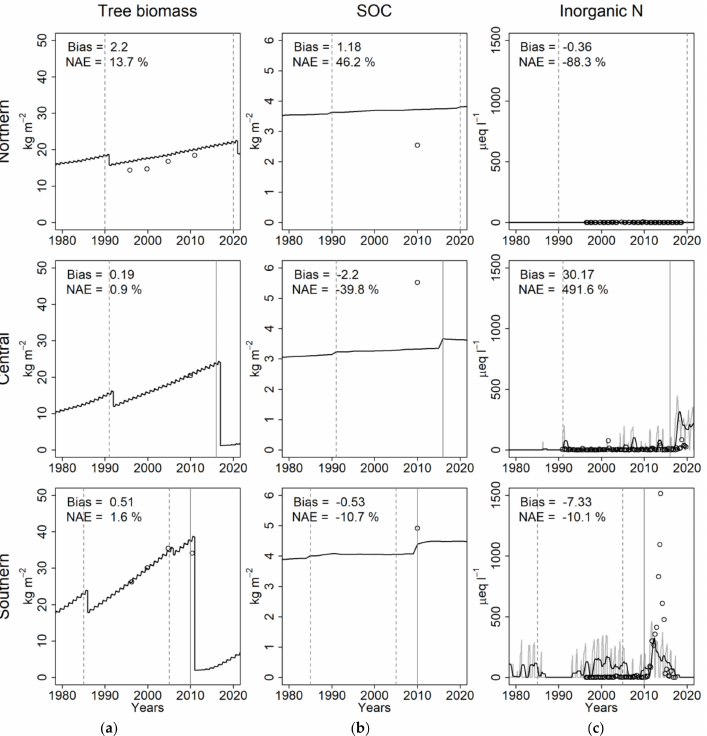
Figure 3. Comparison of modeled data (lines) to measured data (dots) for total biomass, i.e., stem, branches and leaves ( a ), SOC in the organic layer ( b ) and inorganic N, i.e., NO 3 + NH 4 ( c ). The black line represents daily modeled results, except for inorganic N in the soil solution (inorganic N) which is the moving average on a yearly basis of the daily modeled results (grey line). The years when the forest management events occurred are represented by the grey vertical lines—final felling by a solid line and thinning by dotted